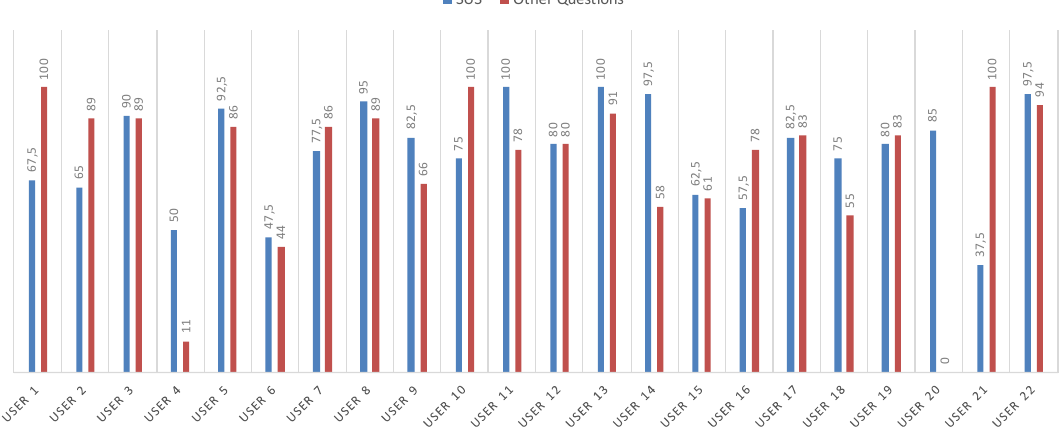
Figure 14. SUS and Navigability scores related to each participant.